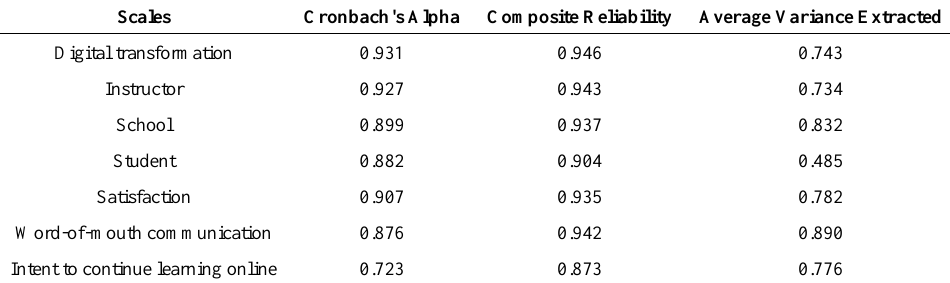
Table 1. The results of testing the reliability of the scales